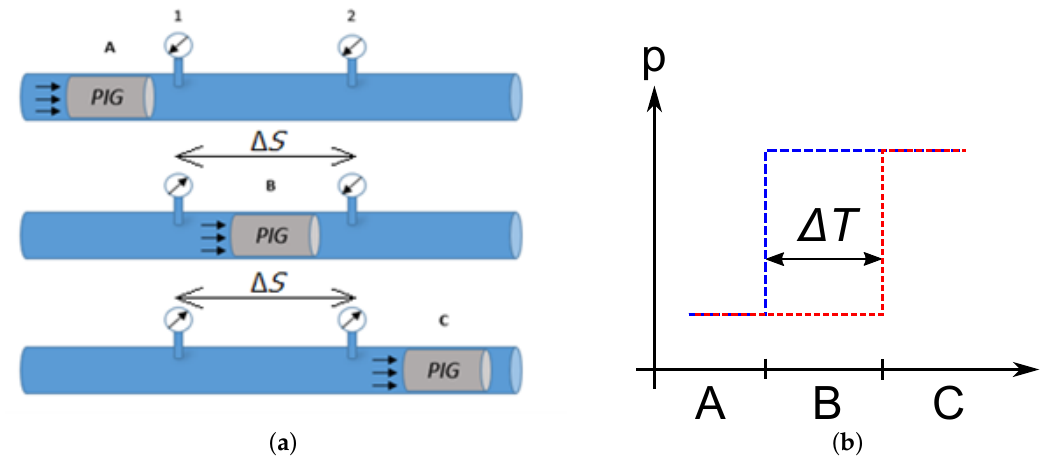
Figure 8. Response and behavior of transducers. ( a ) pipeline stretch with two transducers; ( b ) pressure response. Source: Adapted from